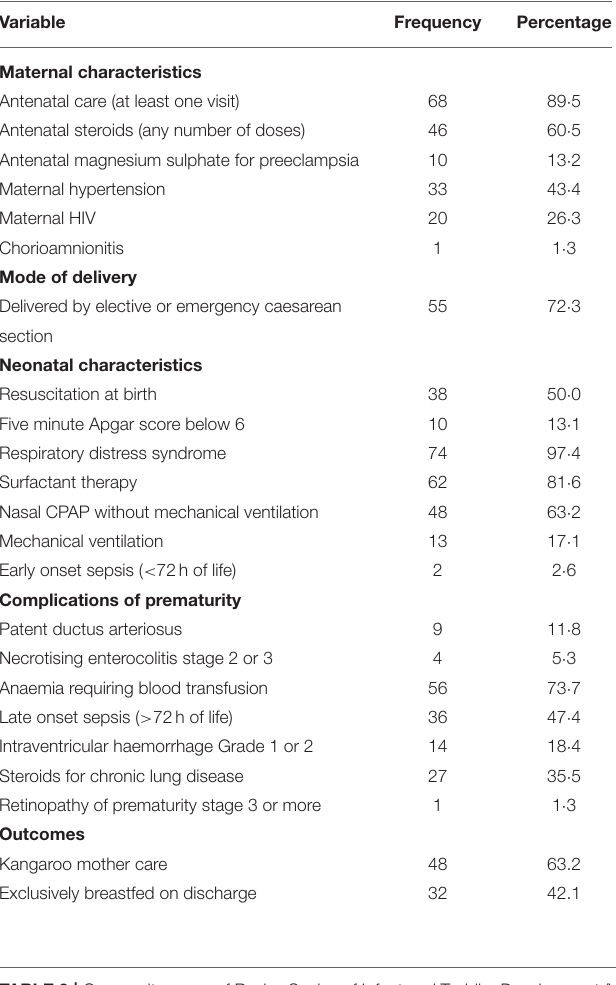
TABLE 2 | Clinical and demographic characteristics of 76 extremely low birth weight infants assessed with Bayley Scales of Infant and Toddler Development (Version III) at a tertiary hospital in Johannesburg, South